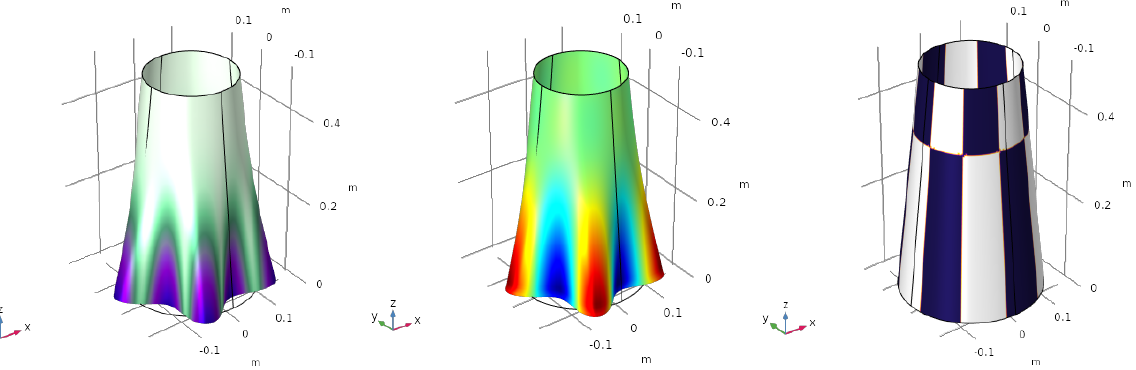
Figure 7. Forth vibration mode f 4 = 299 Hz. Mode shape ( left ), electric charge ( centre ) and optimized electrode profile ( right